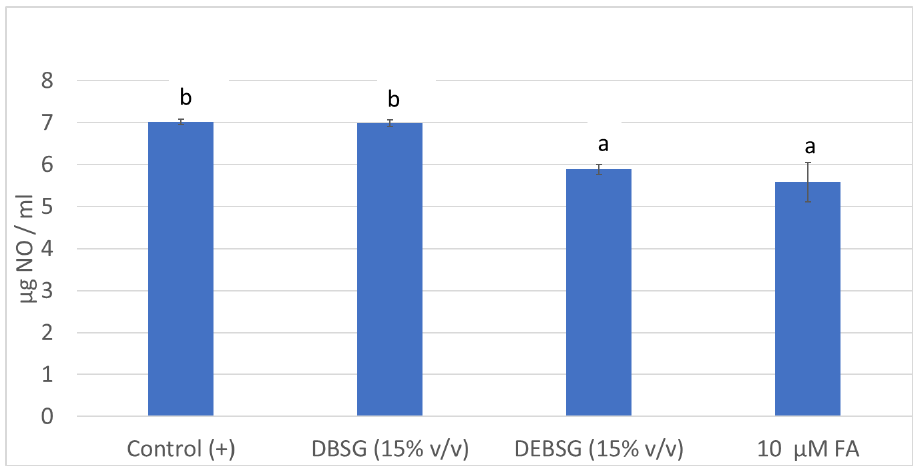
Figure 2. NO formation (µg/mL) in RAW 264.7 induced by LPS (1 µg/mL). Different letters within columns show significant differences ( p < 0.05). DBSG: brewers’ spent grain intestinal digest; DEBSG: extruded brewers’ spent grain intestinal digest; FA: ferulic acid.